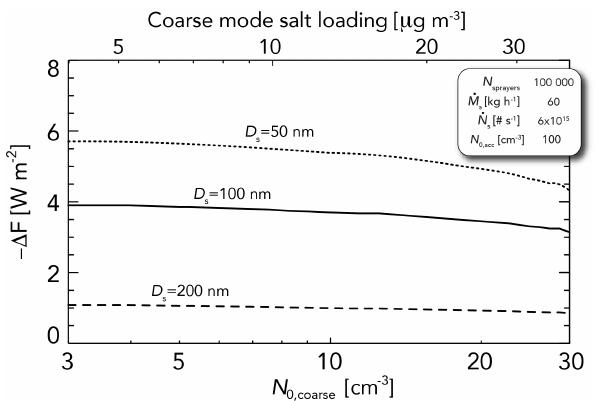
Figure 8. Global mean radiative forcing − (cid:49)F for a fixed salt mass spray rate (based on scenario 2; see the legend) as a function of background coarse-mode aerosol concentration N 0 , coarse for three injected particle sizes ( D s = 50, 100, and 200nm). The equivalent salt mass loading in the coarse mode is indicated by the top axis.